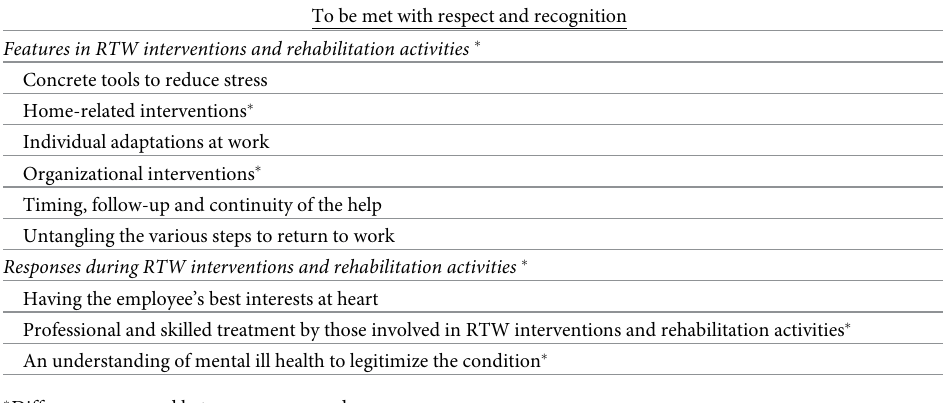
Table 2. Overview of the results. Main and